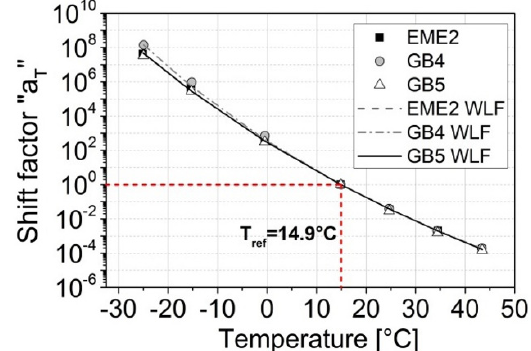
Figure 12. aT coefficient for each mixture.